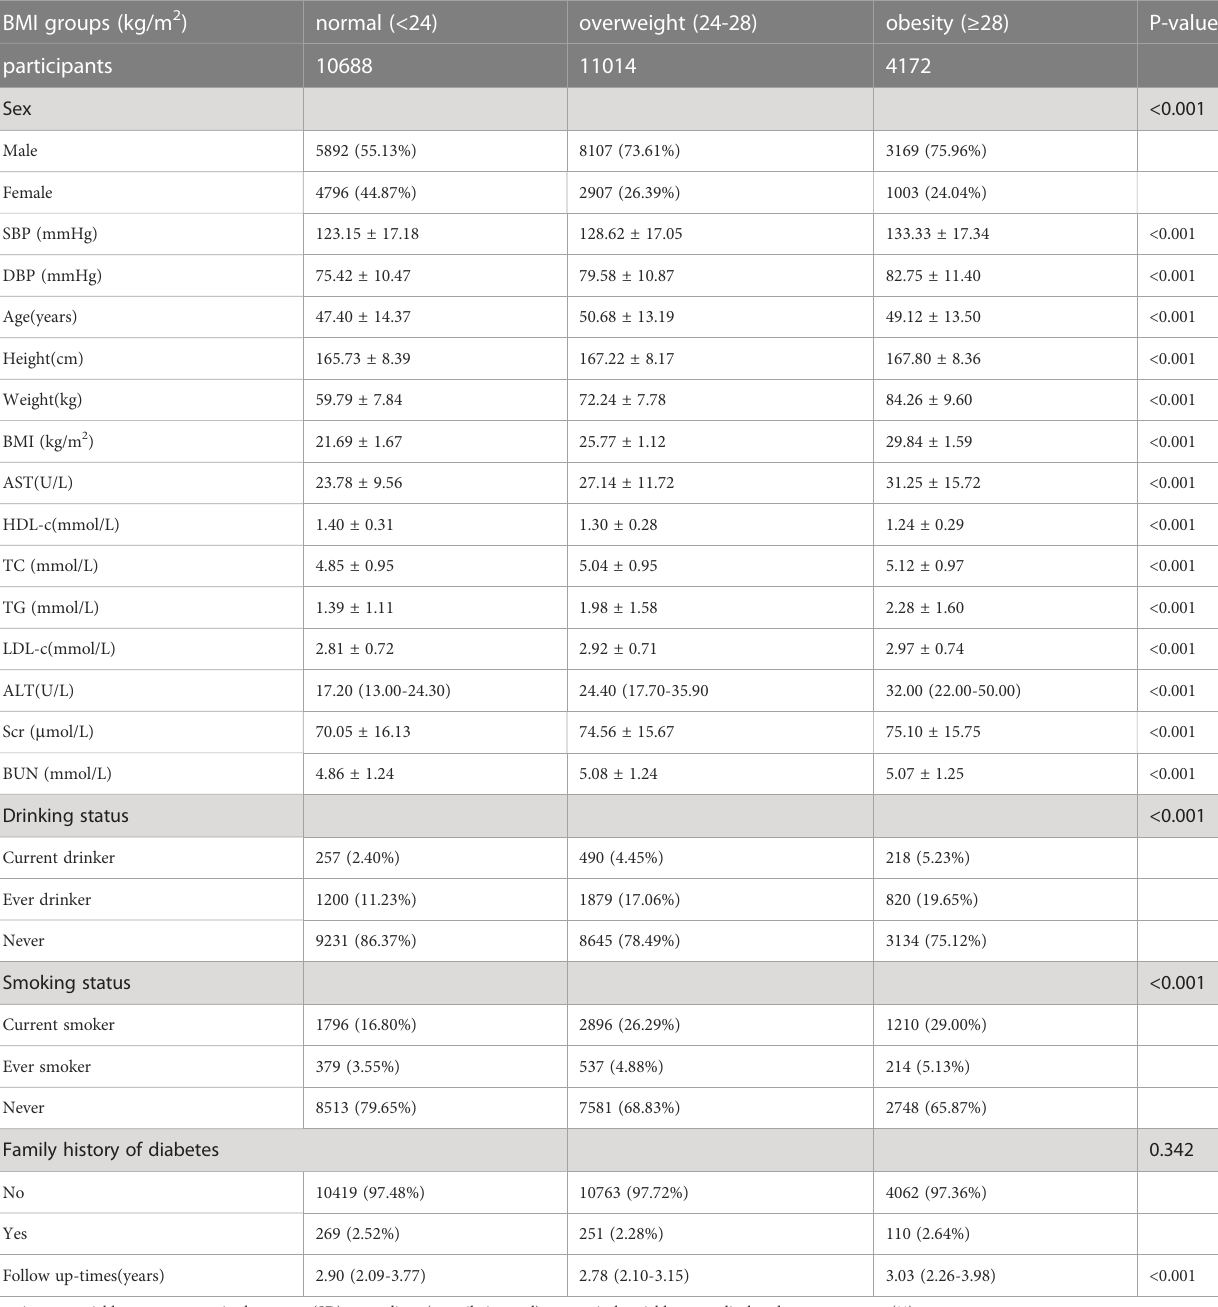
TABLE 1 The baseline characteristics of participants.